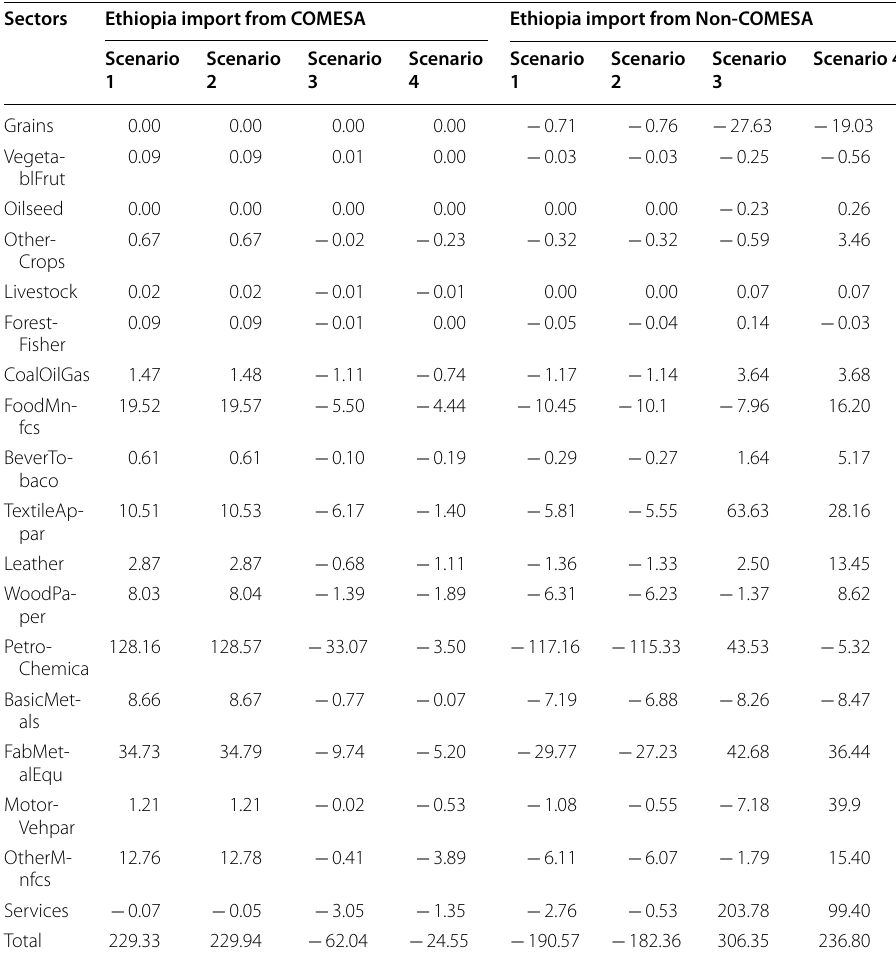
Table 12 Changes in Ethiopia import by source (US$ Million). Source: Model Simulation Sectors Ethiopia import from COMESA